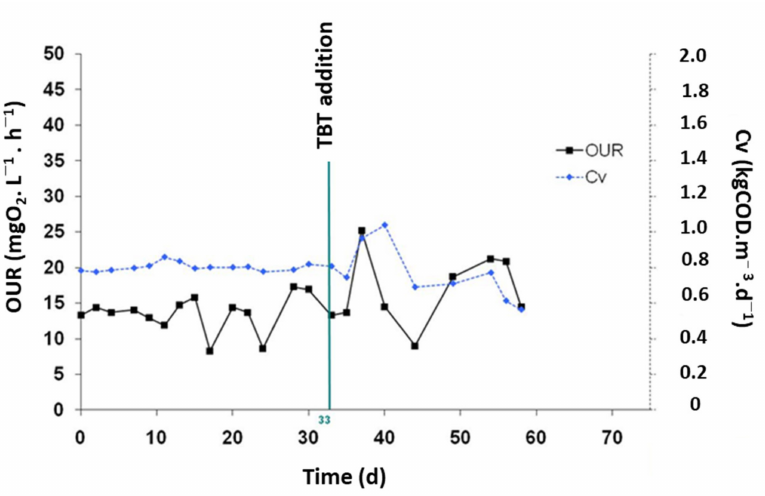
Figure 8. Evolution of the OUR and the organic volume load in MBRi system.